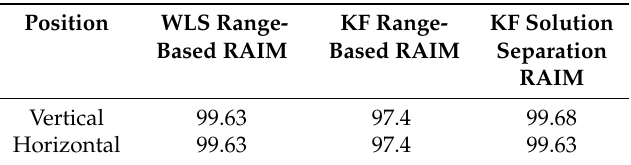
Table 1. RAIM availability in percentage with GPS and NavIC. Position WLS Range- KF Range- KF Solution Based RAIM Based RAIM Separation RAIM Vertical